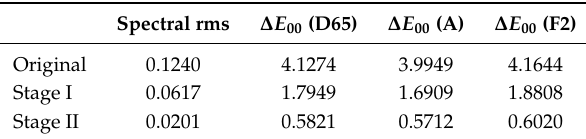
Table 5. Spectral reflectance consistency of the test data. Average spectral rms errors and color difference errors are listed.